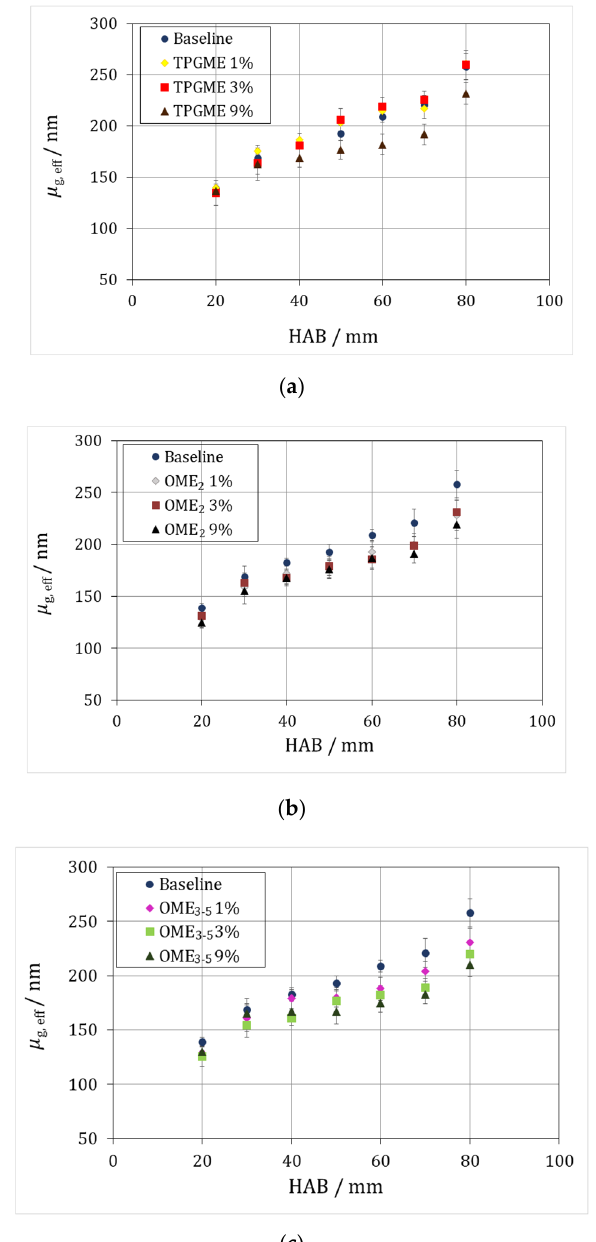
Figure 9. Vertical µ g,eff trends for baseline and ( a ) TPGME–diesel blends (1% vol, 3% vol and 9% vol), ( b ) OME 2 –diesel blends (1% vol, 3%vol and 9% vol) and ( c ) OME 3–5 –diesel blends (1% vol, 3% vol and 9% vol). Error bars represent standard deviation of approx. 200 single-shot results.